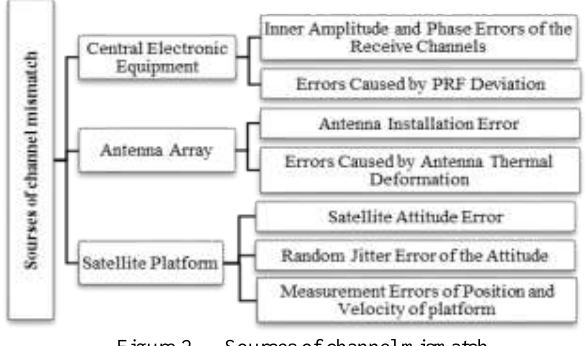
Figure 2. Sources of channel